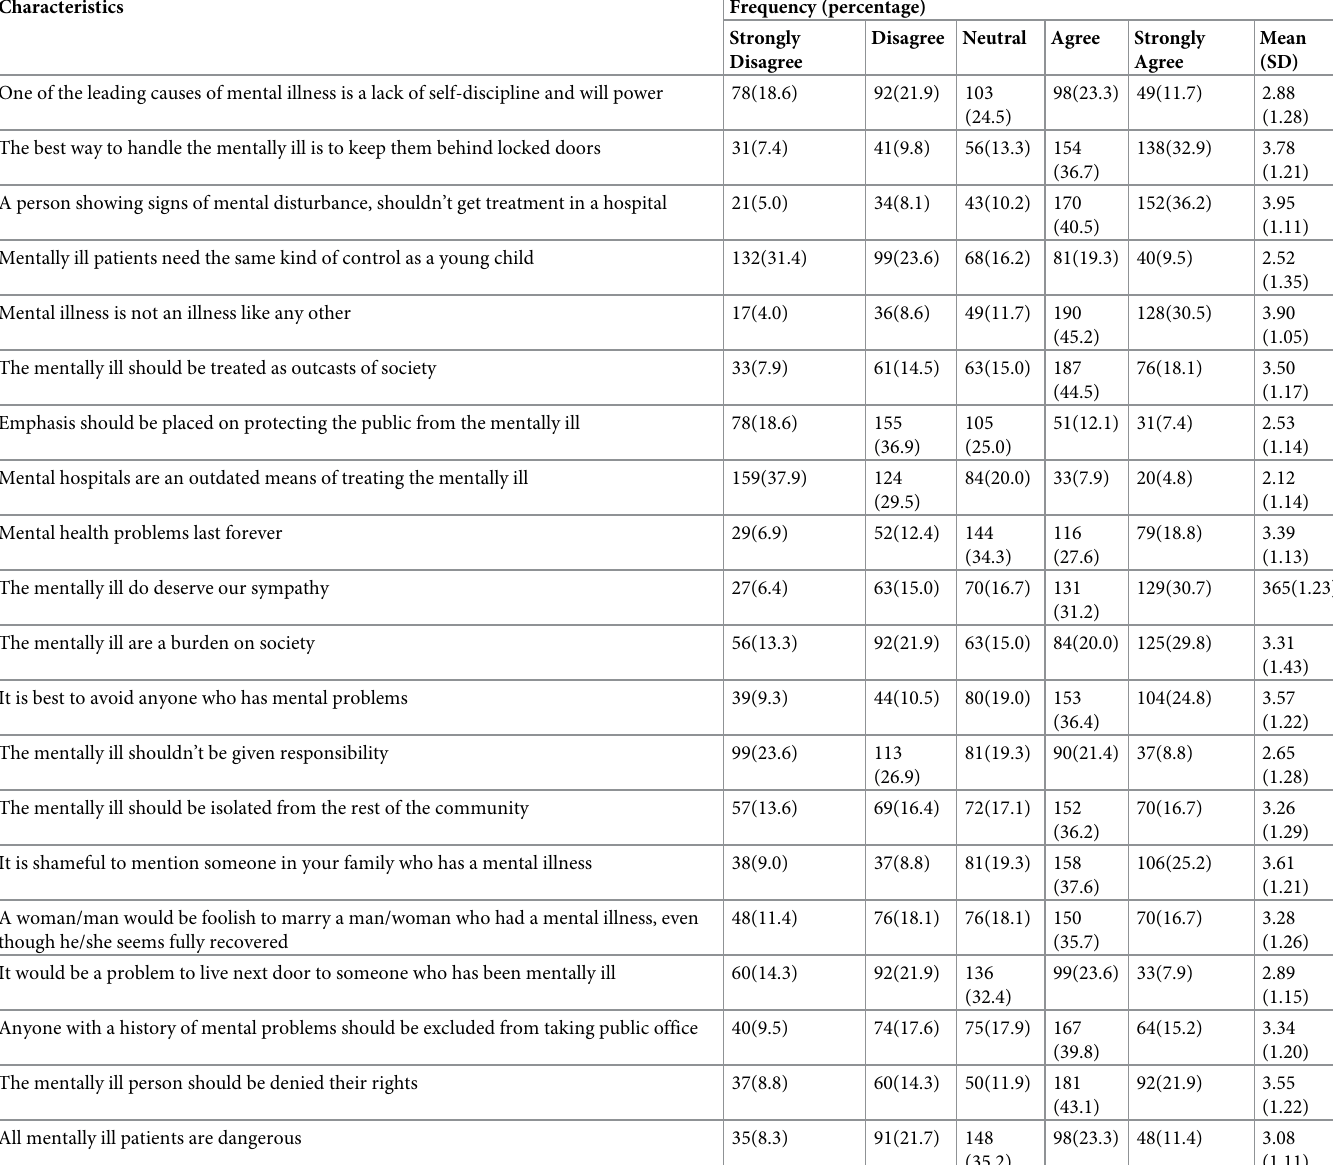
Table 2. Attitude of the respondents towards mental health and mental health problems at Jimma Zone, Seka Chekorsa district Oromia, Ethiopia, March 2020.